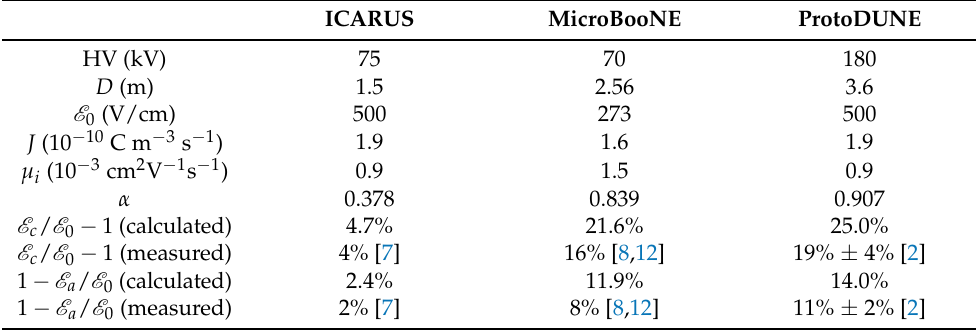
Table 1. Running conditions of the ICARUS, MicroBooNE, and ProtoDUNE experiments and the calculated electric field distortions in comparison with the